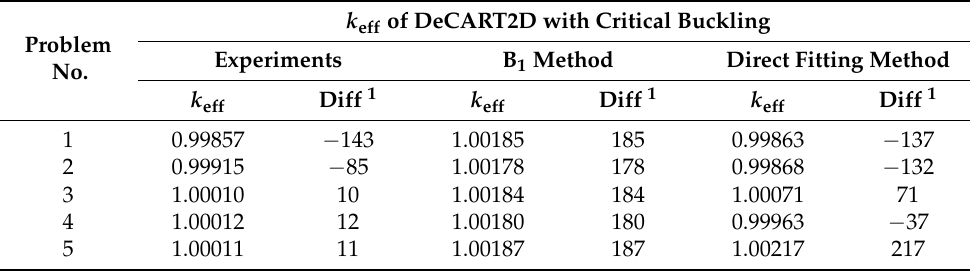
Table 5. k eff of DeCART2D with critical buckling from vertical extrapolation